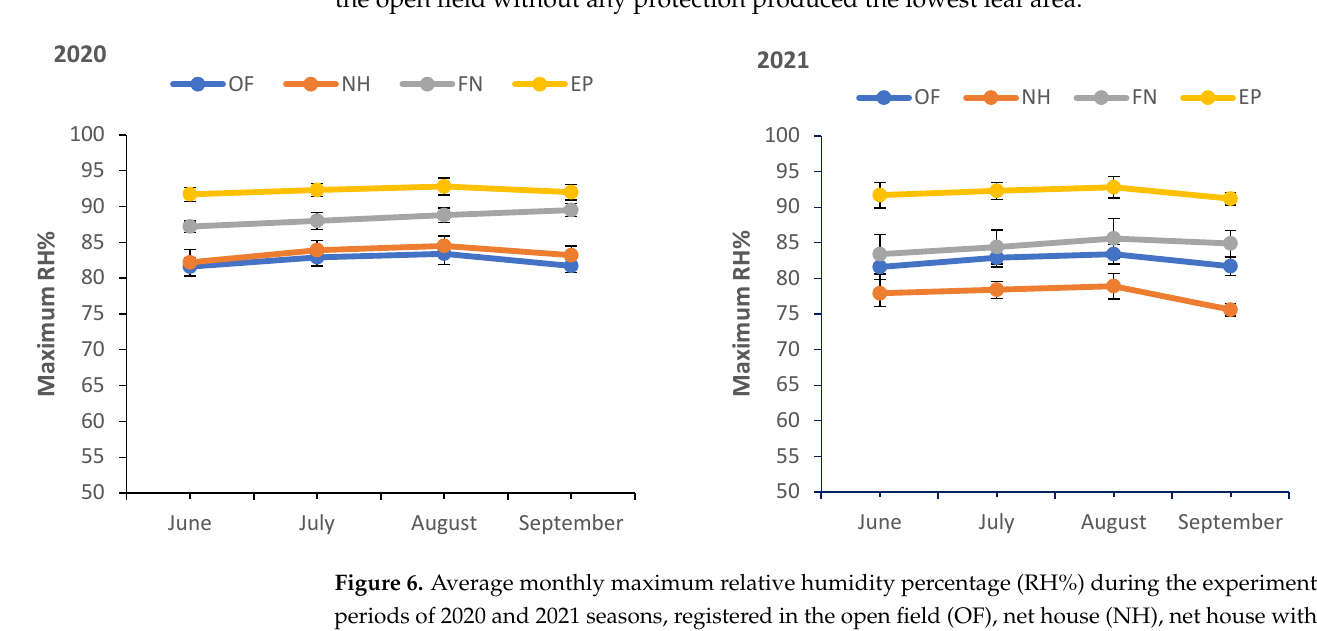
Figure 6. Average monthly maximum relative humidity percentage (RH%) during the experiment periods of 2020 and 2021 seasons, registered in the open field (OF), net house (NH), net house with fogging (NF, operating 6 S/36 S from 10 a.m. to 4 p.m.) and evaporative cooling under plastic house (EP). Standard error of the means was derived three biological replicates.